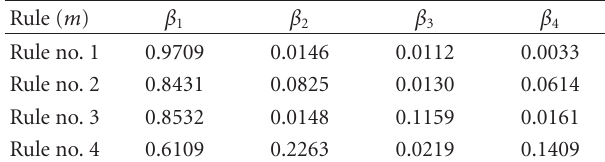
Table 18: Estimated β coe ffi